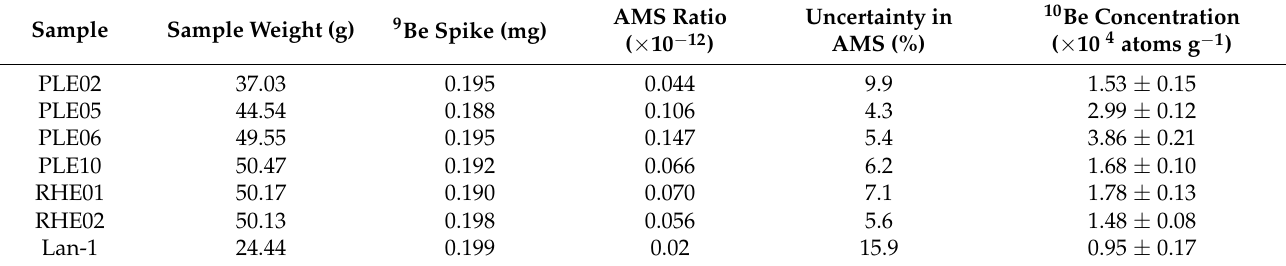
Figure 12. A lithotectonic map of the Plessur Basin (refer to Figure 2 for legend) with main tributaries, denudation rates (DR) in mm a − 1 , and sediment flux (SF) in 10 3 m 3 a − 1 . The numbers at the border of the figure indicate the Swiss coordinates in meters. Table 5. Cosmogenic nuclide